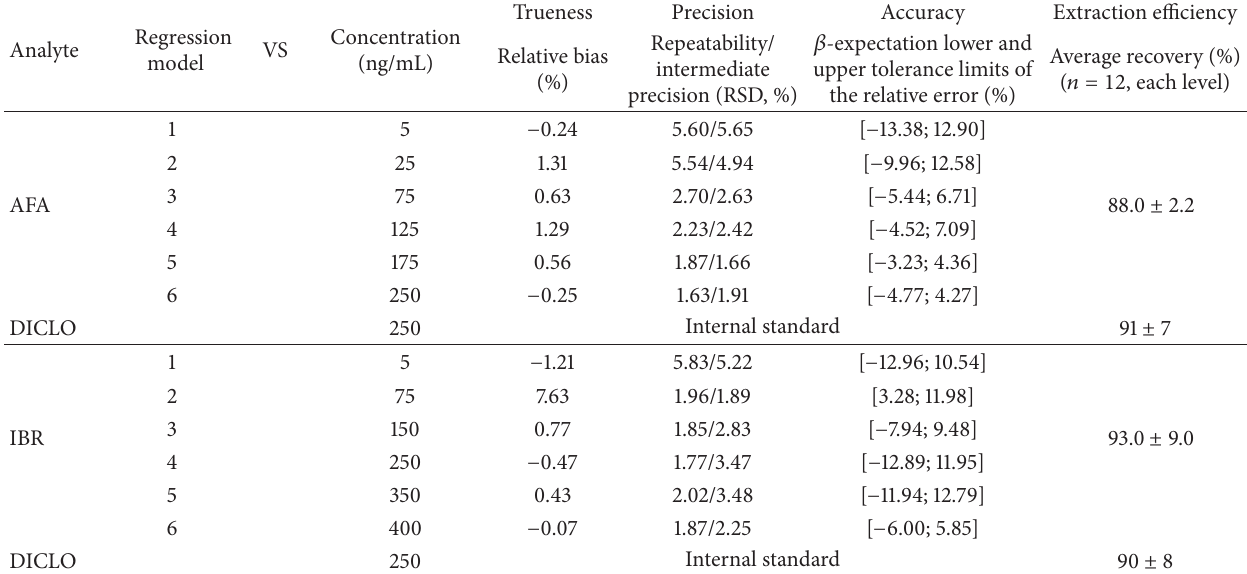
Table 1: Validation data of linear regression of AFA and IBR in human plasma.